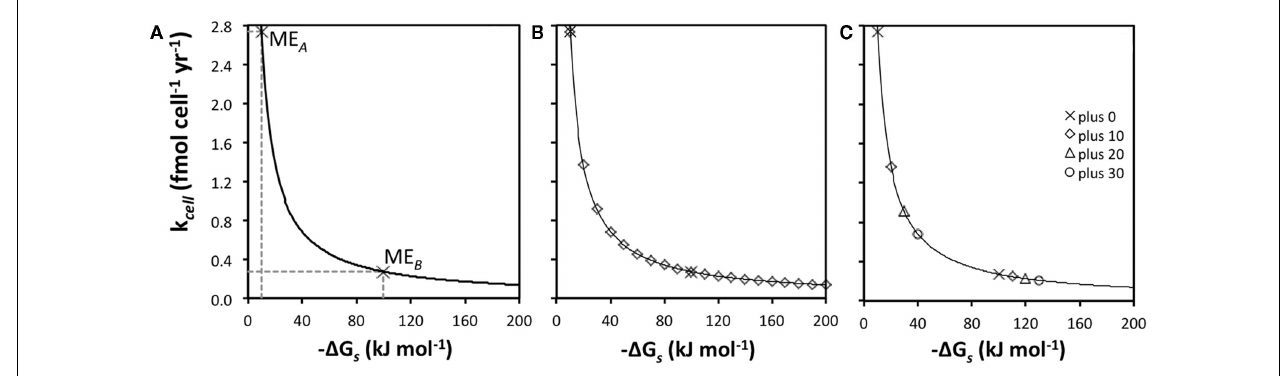
) and = − 100 kJ mol − 1 ) and a low k FIGURE 3 | Relationships between energy yields per substrate ( Δ G (cid:3) high-energy yields ( Δ G (cid:3) cell . (B) Illustration of the s s turnover rate ( k cell ). (A) Hyperbolic relationship between Δ G (cid:3) effect of 10kJmol − 1 increments in energy yields per substrate on the turnover and k cell s rate required to meet ME cell . (C) Turnover rates for ME A and ME B (“plus 0”) assuming ME cell = 2.74 × 10 − 14 kJ cell − 1 year − 1 . ME A and ME B indicate two different strategies to meet ME cell , ME A for a substrate with low-energy yields compared to competing reactions “plus 10,” “plus 20,” and “plus 30” with 10, ( Δ G (cid:3) = − 10 kJ mol − 1 ) and a high k 20, and 30kJmol − 1 higher energy yields per substrate, cell , and ME B for a substrate with s